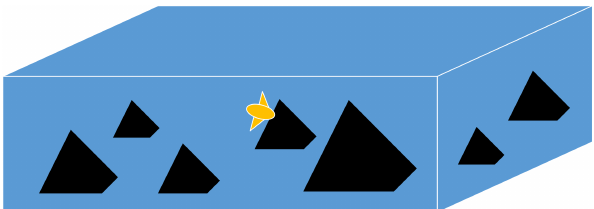
Figure 2. Three-dimensional underwater area with the riverbed.